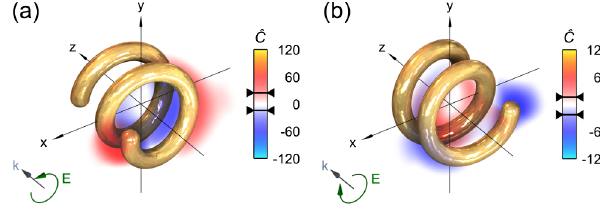
FIG. 2. Optical chirality enhancement for (a) a left-handed helix with left-handed circularly polarized light and (b) a right-handed helix with right-handed circularly polarized light at a wavelength of 2 : 03 (cid:1) m . Diameter and height of the helix are 400 nm with a gold thickness of 80 nm. Both combinations show enhanced optical chirality where the values of maximum and minimum enhancement are denoted by the black horizontal lines across the color bars. The regions with enhanced optical chirality are located at corresponding positions of the respective helix, but their signs flip. The pictures addressing the polarization state are taken from the detector’s view; hence, the direction of the arrow indicates the handedness of the field vectors in space at a fixed time.